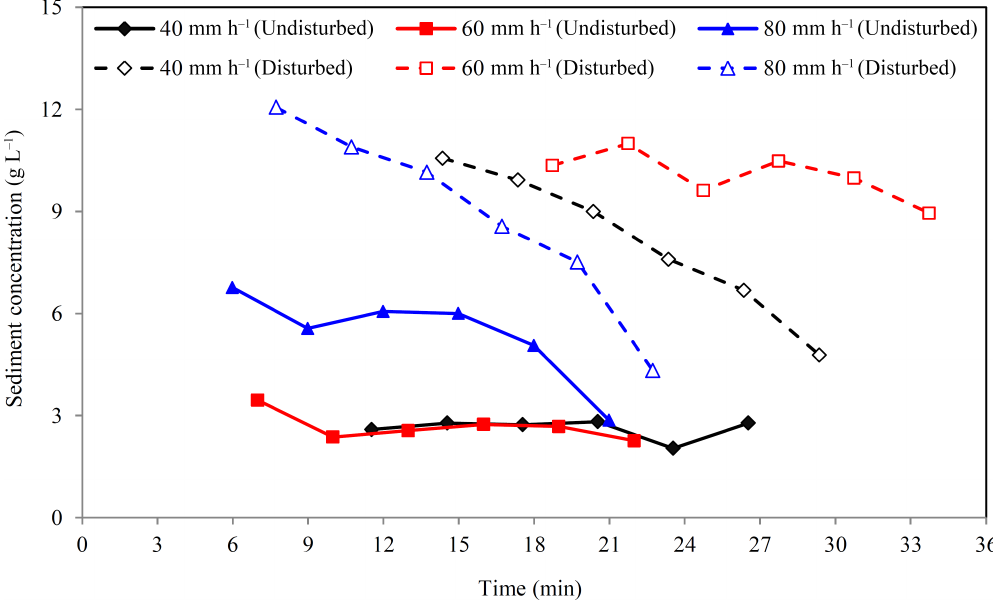
Figure 3. Mean temporal variation of sediment concentrations in three replications before and after soil preparation